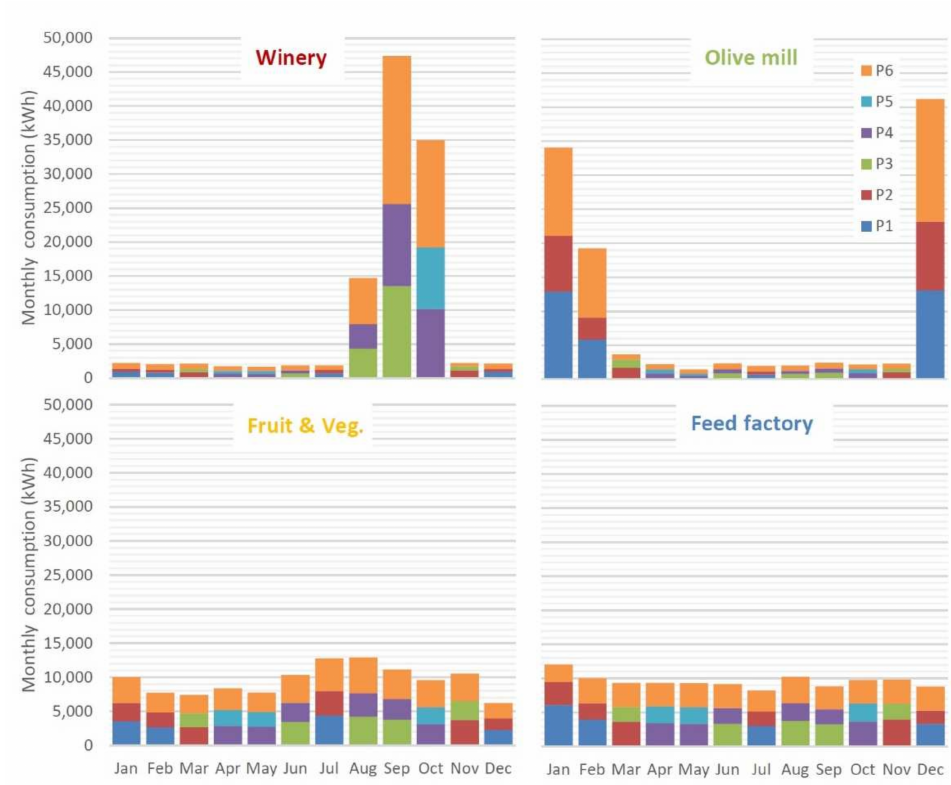
Figure 5. Monthly energy consumption broken down into the different periods of the new tariff